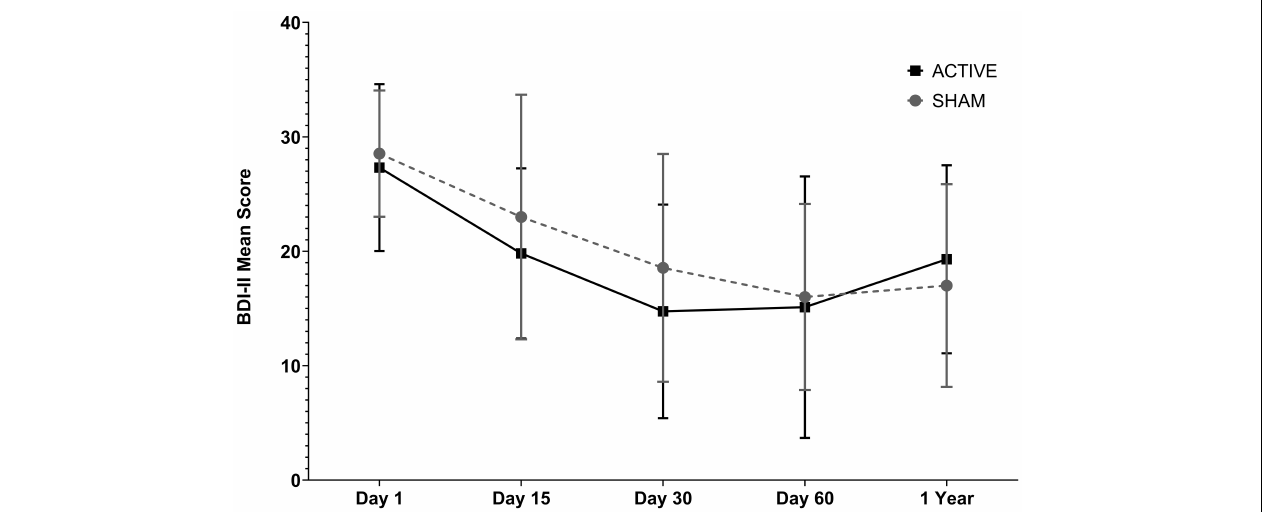
FIGURE 2 | Assessment of depressive symptoms in the Sham and Active groups (using the Beck II Depression Inventory - BDI-II) during five stages (i) pre-treatment; (ii) after 10 sessions of tDCS; (iii) after 20 daily sessions, and (iv) after 1 month of follow-up performing tDCS once a week for 3 weeks; (v) 1 year after treatment. Data arereported as mean + SD score on the BDI-II scale. Data analysis was performed using the Generalized Estimating Equations model (GEE). There was no statistically significant difference between groups considering the type of treatment.